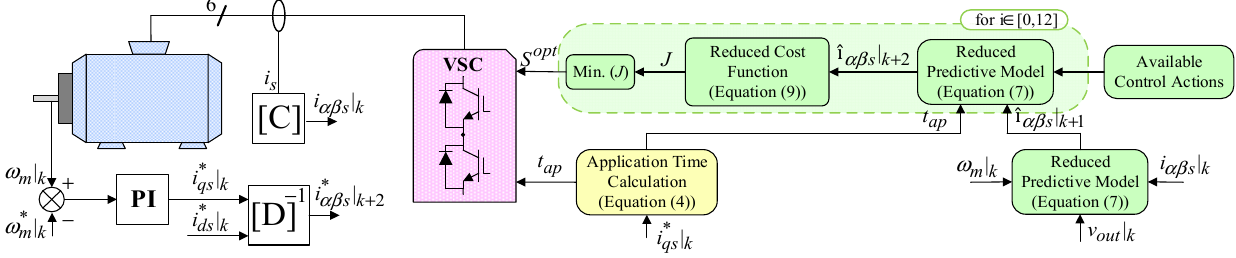
Figure 5. Proposed PULLA-MPC control scheme.